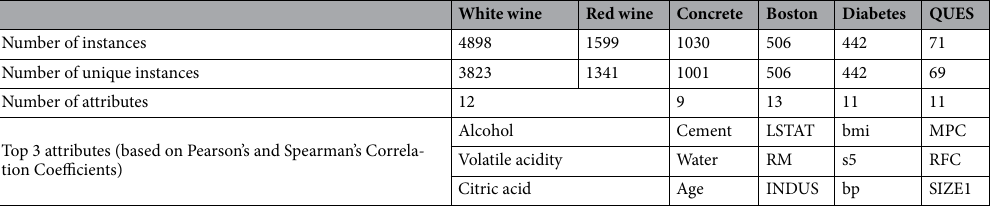
Table 6 summarized the performance TI and PI of the three models: FCM, FCM-PSO, FCM-FN. TI is related to the structure of models directly. The FCM and FCM-PSO have the same structure and TI (= 4). By contrast, the FCM-FN model is with non-identity nodes and connections and lower TI (= 1). PI is related to both the structure and parameters. Though FCM and FCM-PSO have the same structure, but the latter tunes the parameters and